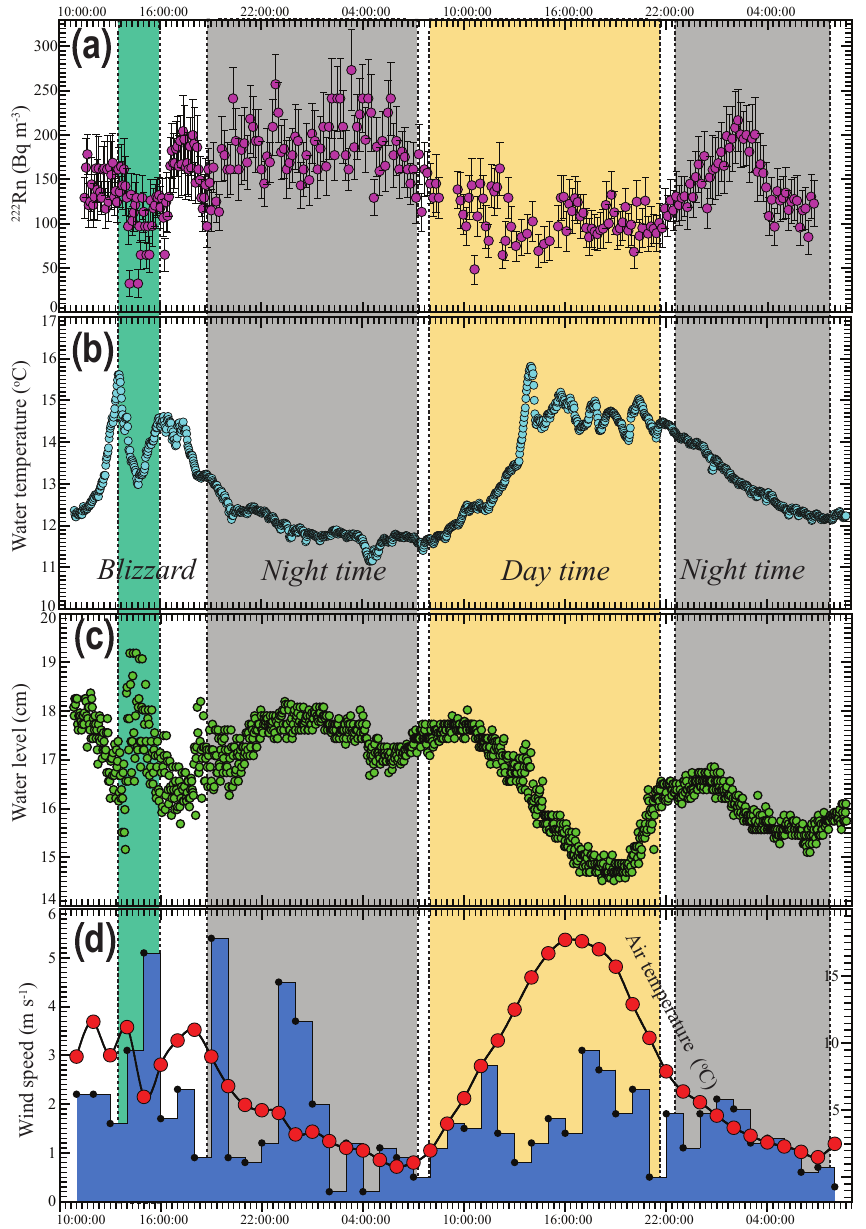
Figure 3. The temporal distributions of 222 Rn (a) , water temperature (b) , water level fluctuation recorded by the divers (c) , and hourly wind speed and air temperature recorded in Jiuzhi weather station (d)